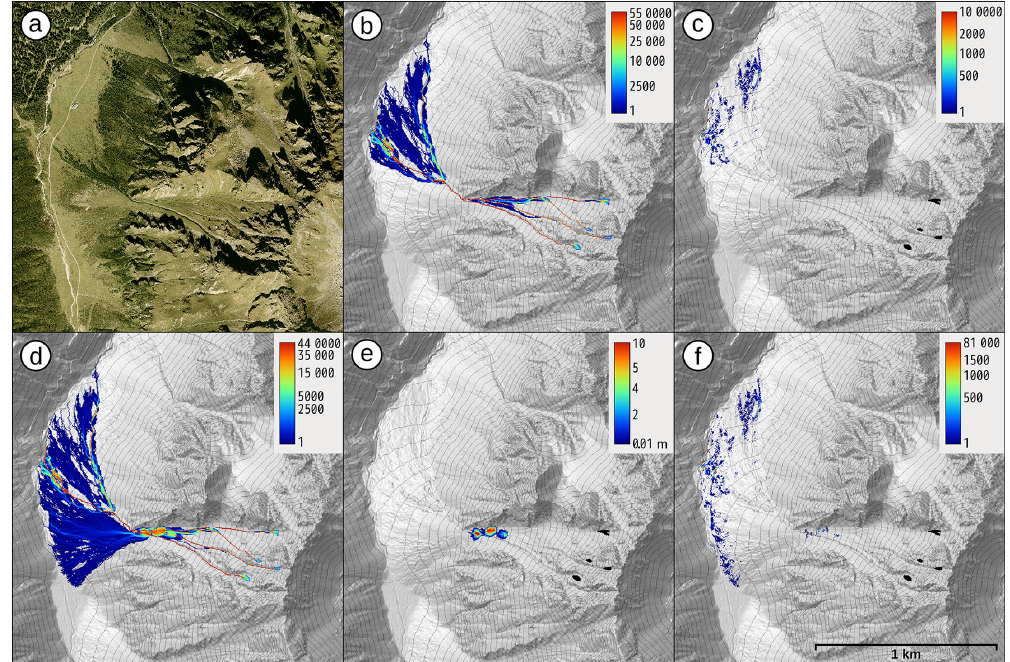
Figure 8. Deposition modeling scenario on a high-resolution 2.5m DTM: (a) orthophoto, (b) transition frequencies (no deposition), (c) stop- ping positions (no deposition), (d) transition frequencies (deposition), (e) material deposition heights, (f) stopping positions (deposition). For details see